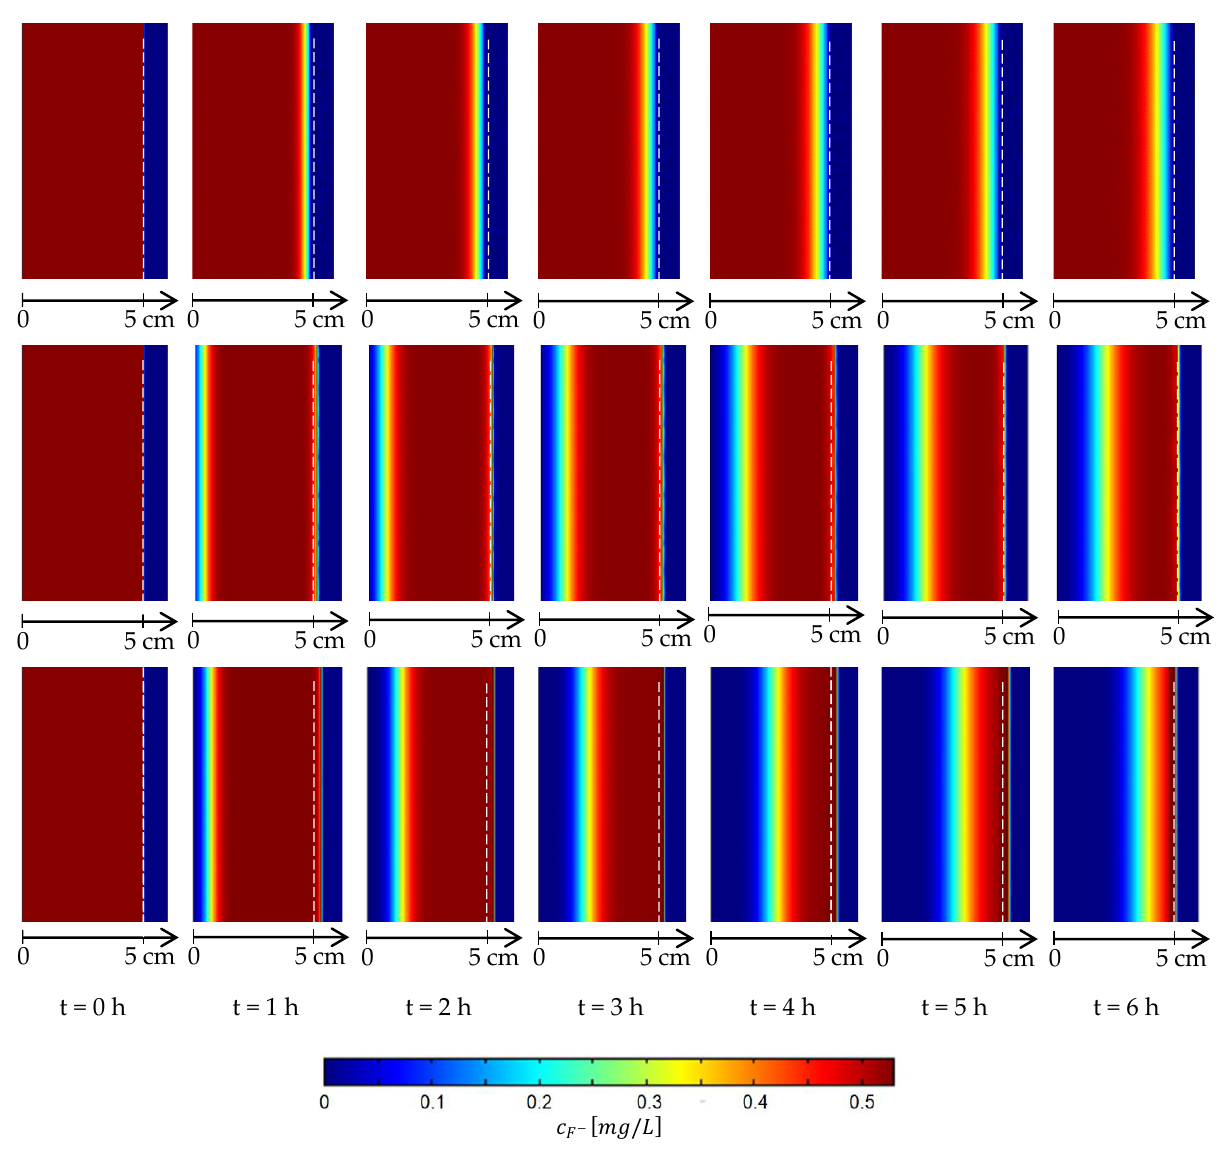
Figure 2. Fluoride concentration (mg/L) in the system as a function of time (t) for w w = 5 cm and c n 0 = 10 mg/L and applied voltage of 0 V (first row), 0.5 V (second row), and 1 V (third row). Table 2. Time required to reduce the fluoride concentration below the limit of 1.5 mg/L as a function of applied voltage V 0 , c no , and w w